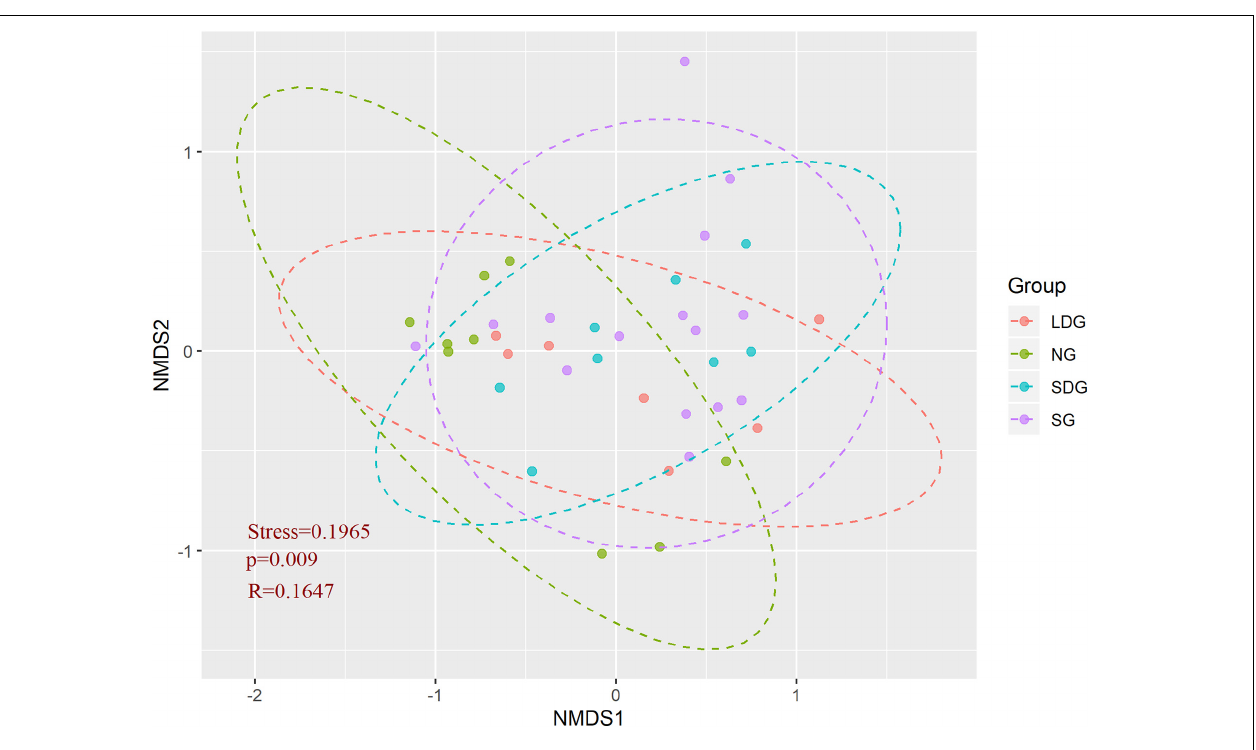
FIGURE 6 | Non-metric multidimensional scale (NMDS) analysis of soil asymbiotic nitrogen-fixing microorganisms in 39 study sites. Group refers to different types of grassland, NG (green dots and dotted lines), natural grassland; SG (purple), sown grassland; LDG (red), lightly degraded grassland; SDG (blue), severely degraded